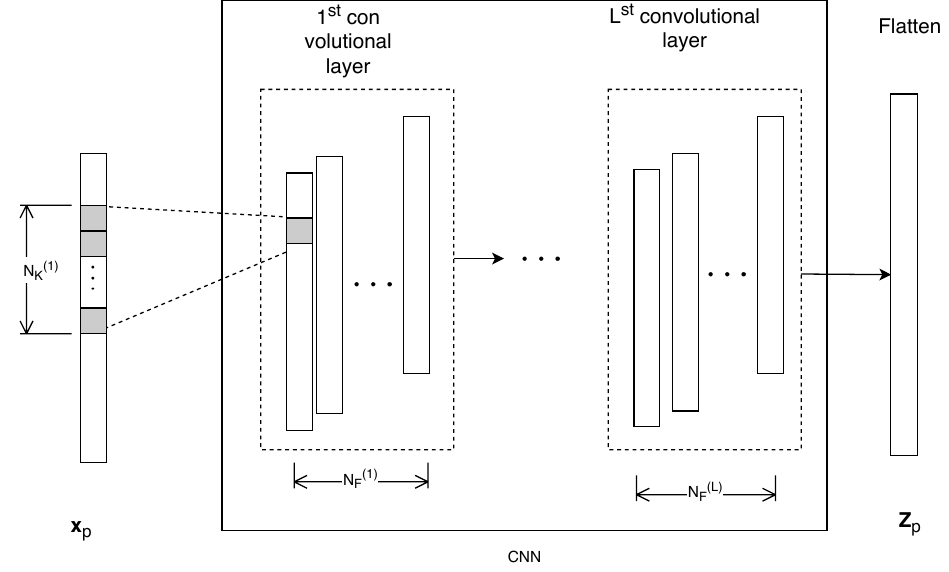
Figure 3. Proposed one-dimensional CNN